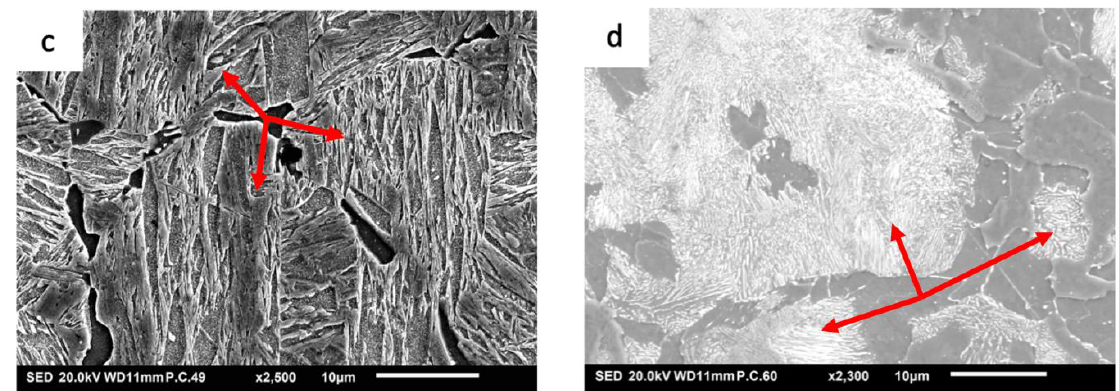
Figure 2. Optical and SEM micrographs of the samples after the heat treatments: ( a ) FM microstructure, ( b ) FP microstruc- ture, ( c ) detail of the martensite phase, ( d ) detail of the pearlite phase. In ( c ) and ( d ), the darker phase is ferrite.